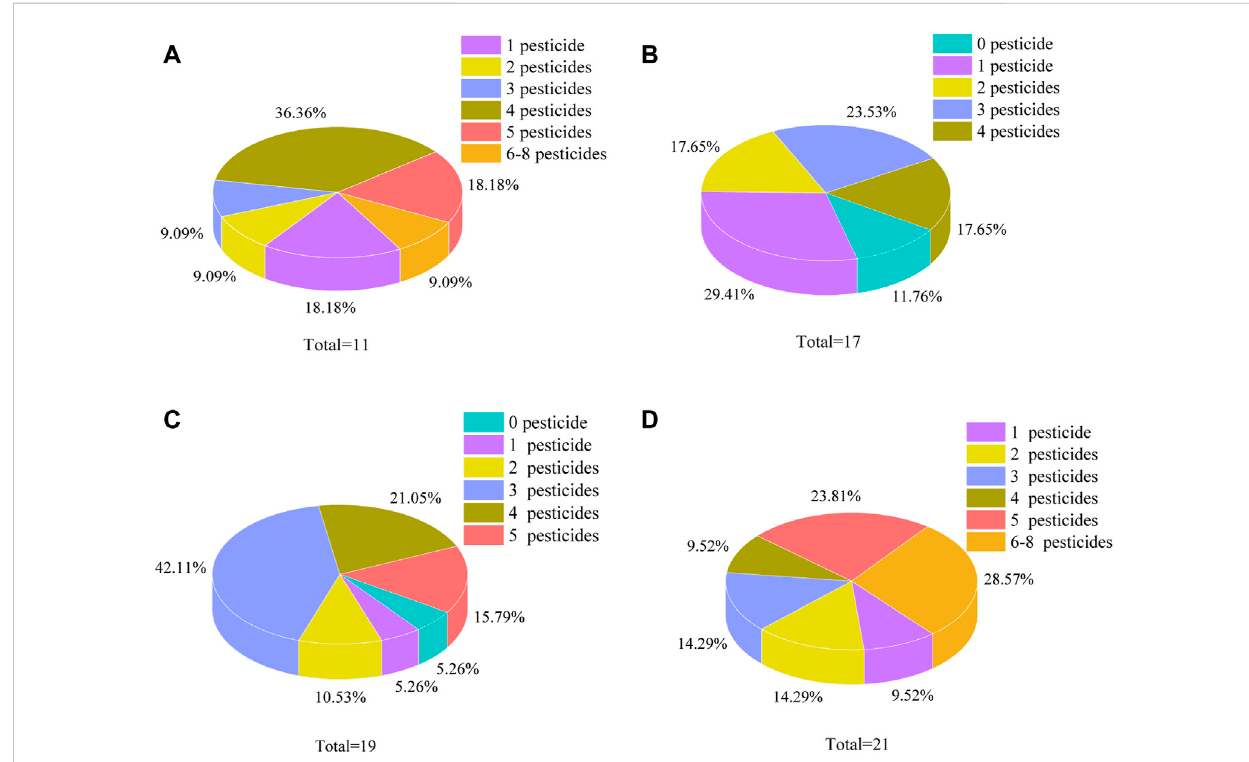
Proportion of pesticide residues in samples of yellow peach (A) , loquat (B) , sweet spring tangelo (C) and pear (D)